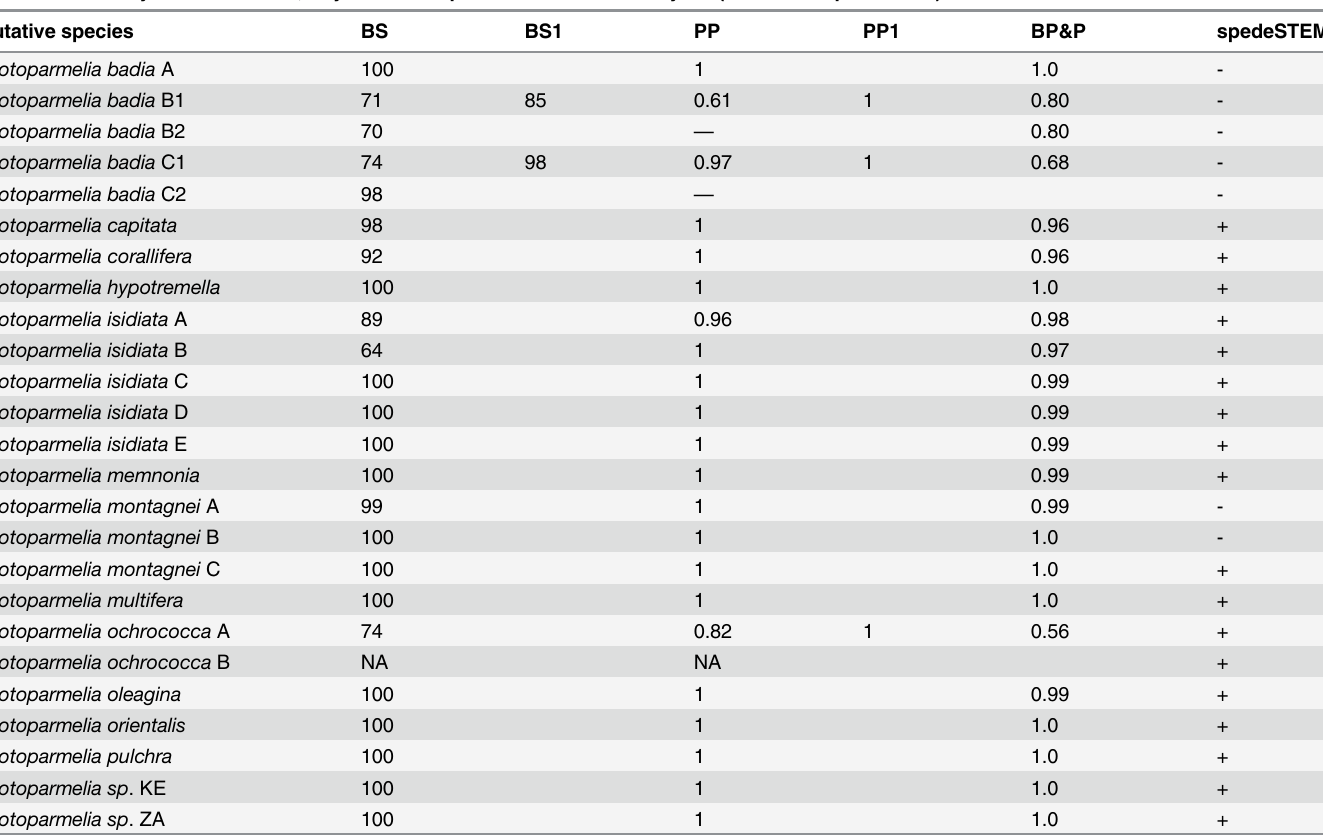
Table 4. Summary of results of ML, Bayesian and species delimitation analyses (BP&P and spedeSTEM). Putative